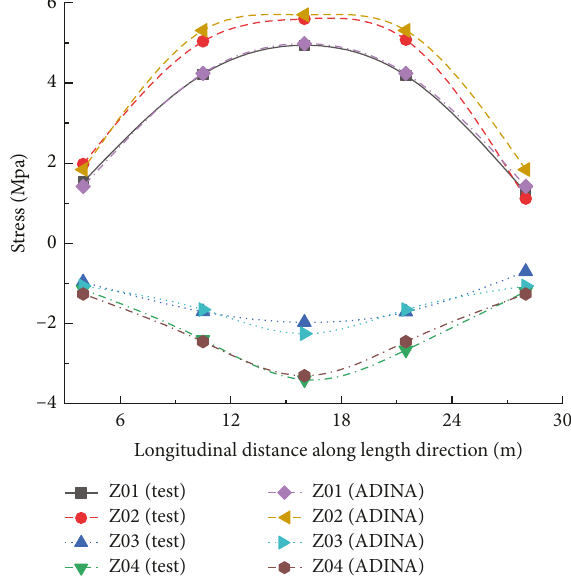
Figure 18: Stress increment along the girder length